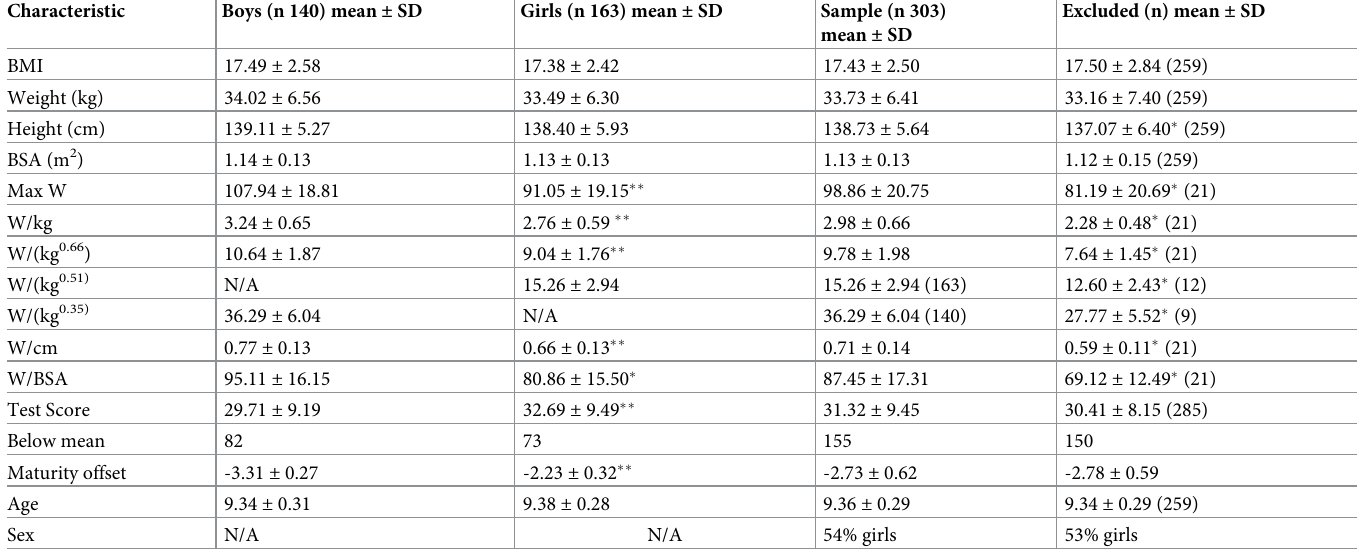
Table 1. Physical characteristics of the study sample and excluded